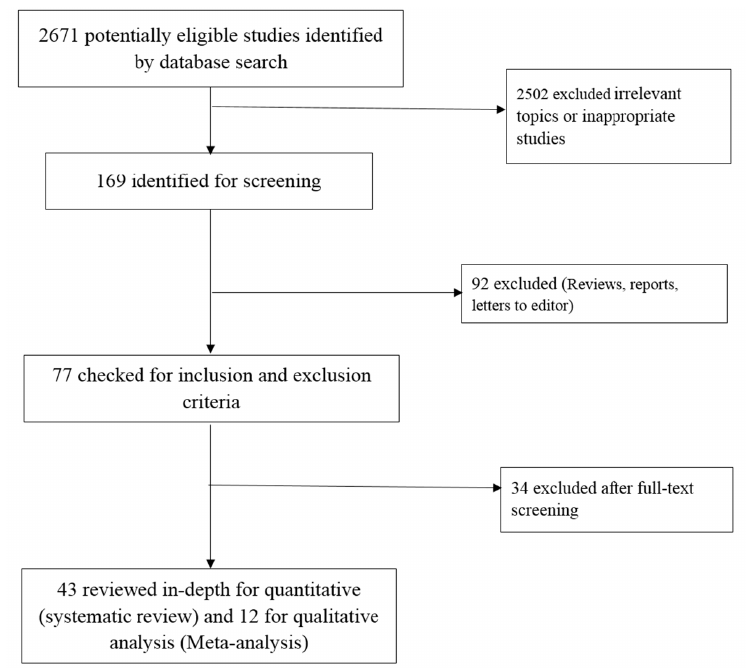
Figure 1. Flowchart of the literature study process and selection.